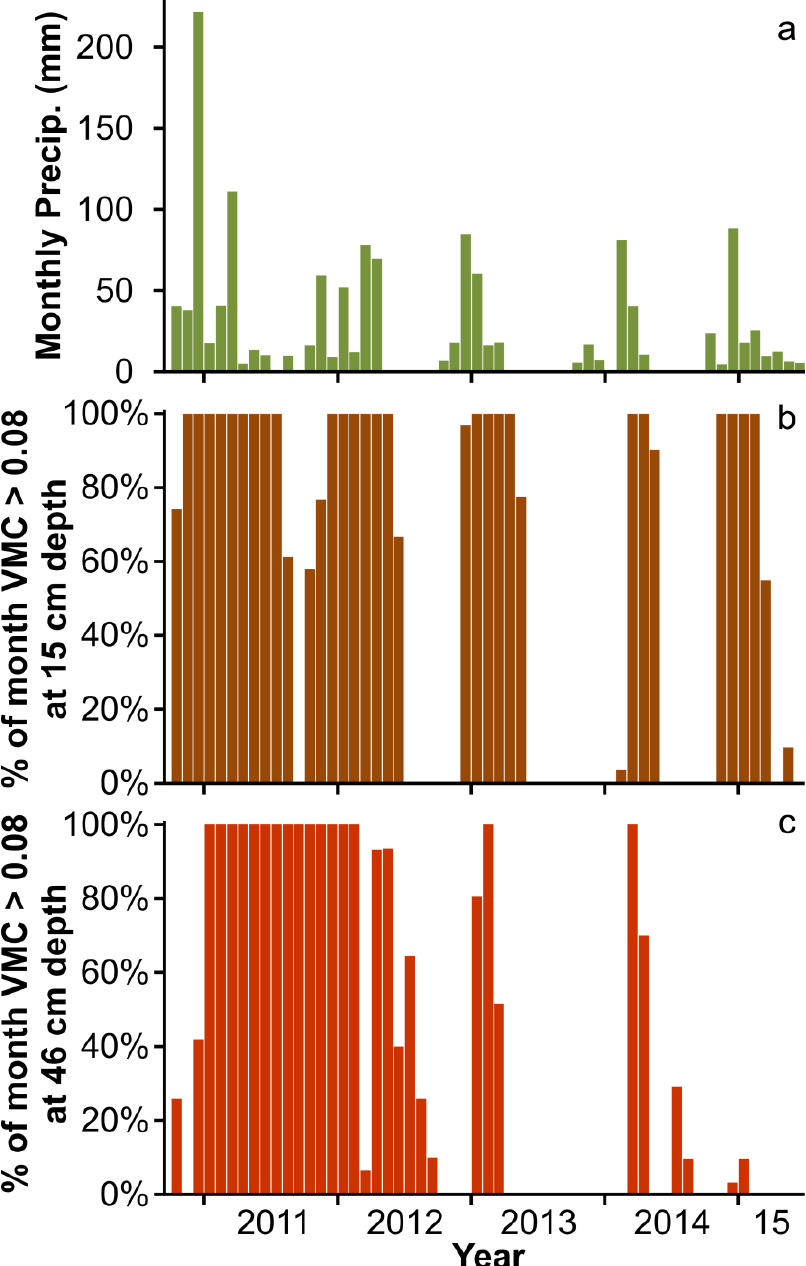
Figure 2. Precipitation and soil moisture measured at Sedgwick Ranch, California. ( a ) Monthly precipitation; ( b ) percent of each month with a volumetric moisture content (VMC) greater than 0.08 at a depth of 15 cm. The 0.08 VMC threshold was empirically determined to be just above the wilting point in this soil type; and ( c ) percent of each month with a VMC greater than 0.08 at a depth of 46